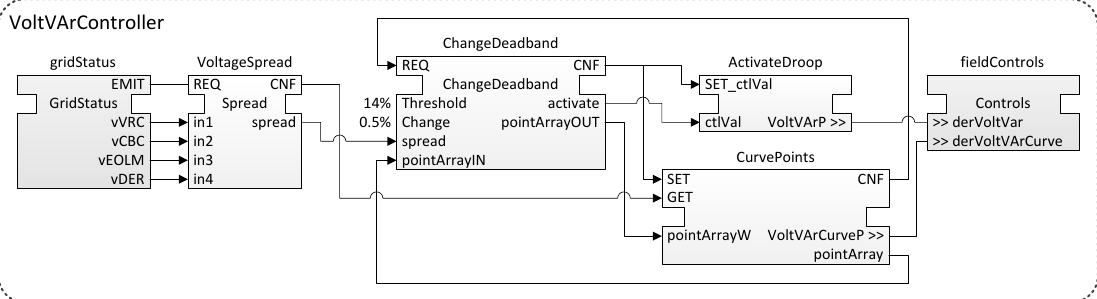
Figure 12. Implementation of the VoltVArController SubApp 499 from Figure